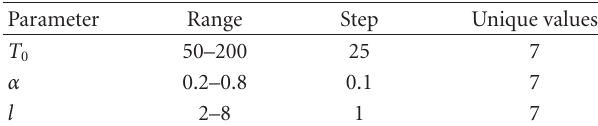
Table 4: Parameter combinations for testing of the stochastic search